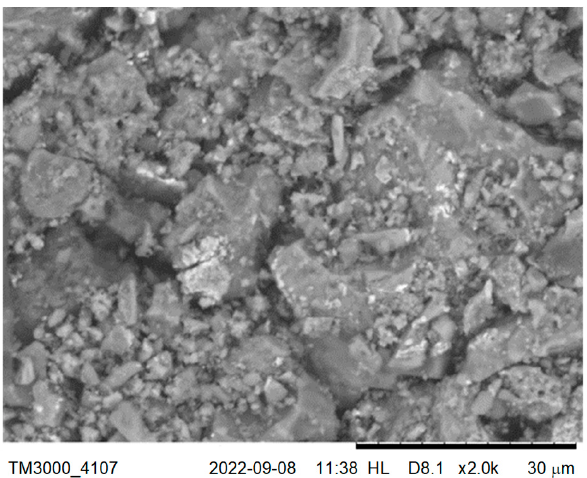
Figure 8. The SEM image of the slag from thermal conversion of sewage sludge.